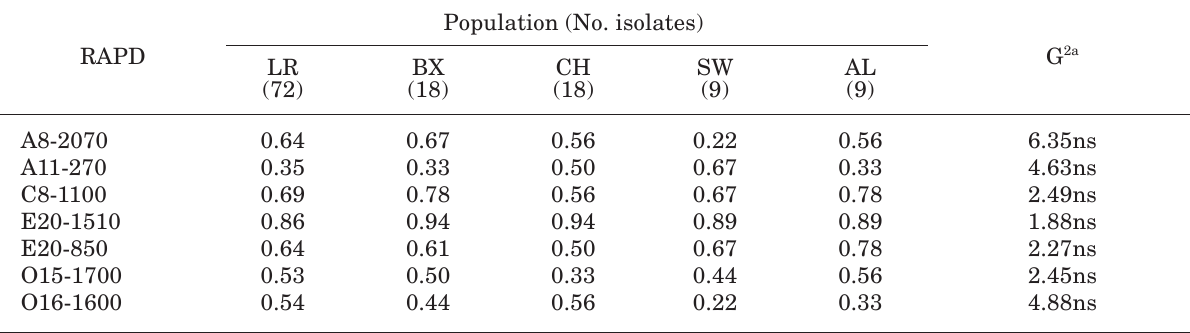
Table 6. Frequency of seven RAPD markers and differentiation in Phaeoacremonium chlamydosporum populations from Languedoc-Roussillon (LR), Bordelais (BX), Charentes (CH), South-West (SW), and Alsace